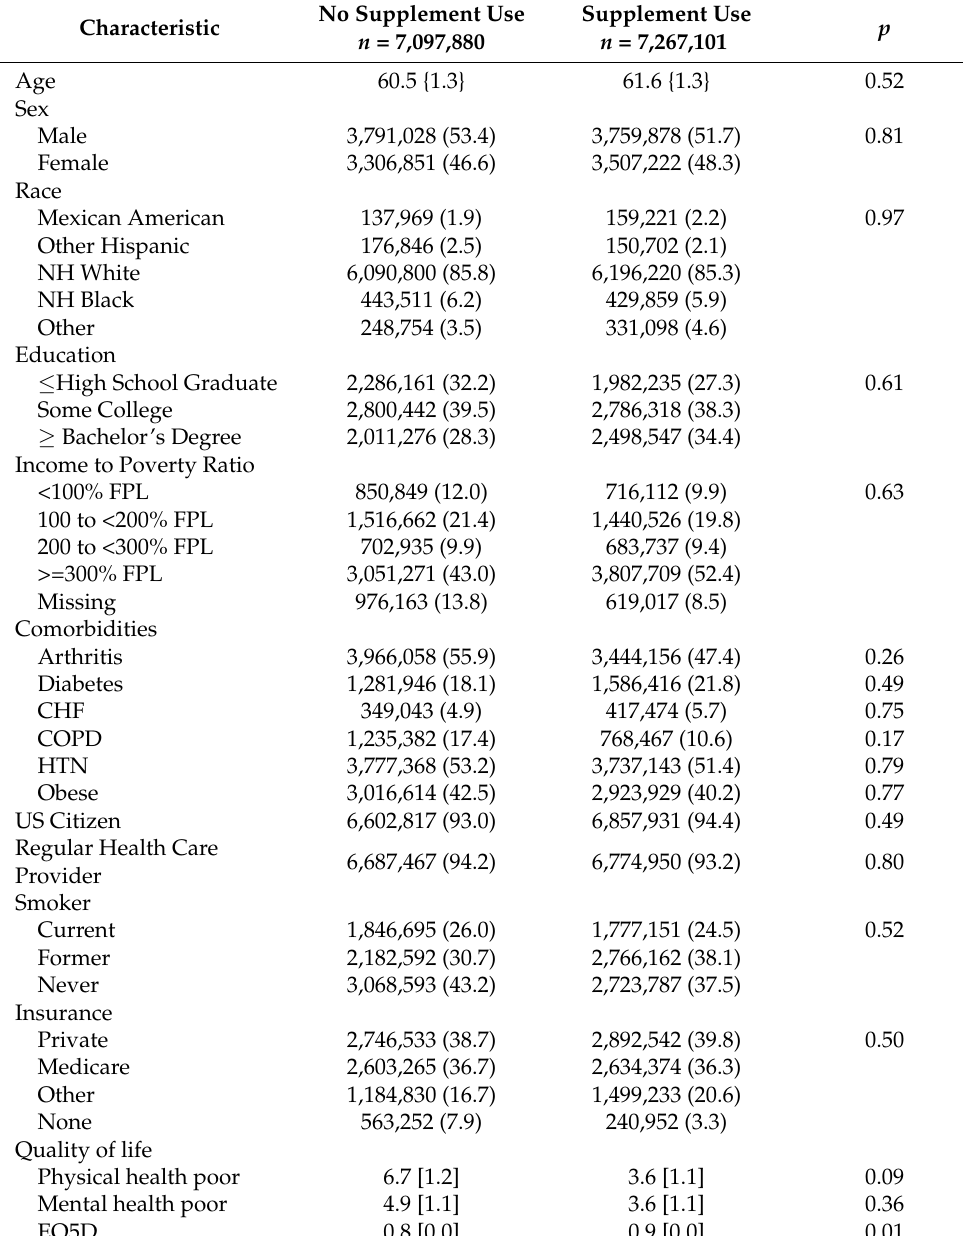
Table 1. Population characteristics by prior 30 day dietary supplement